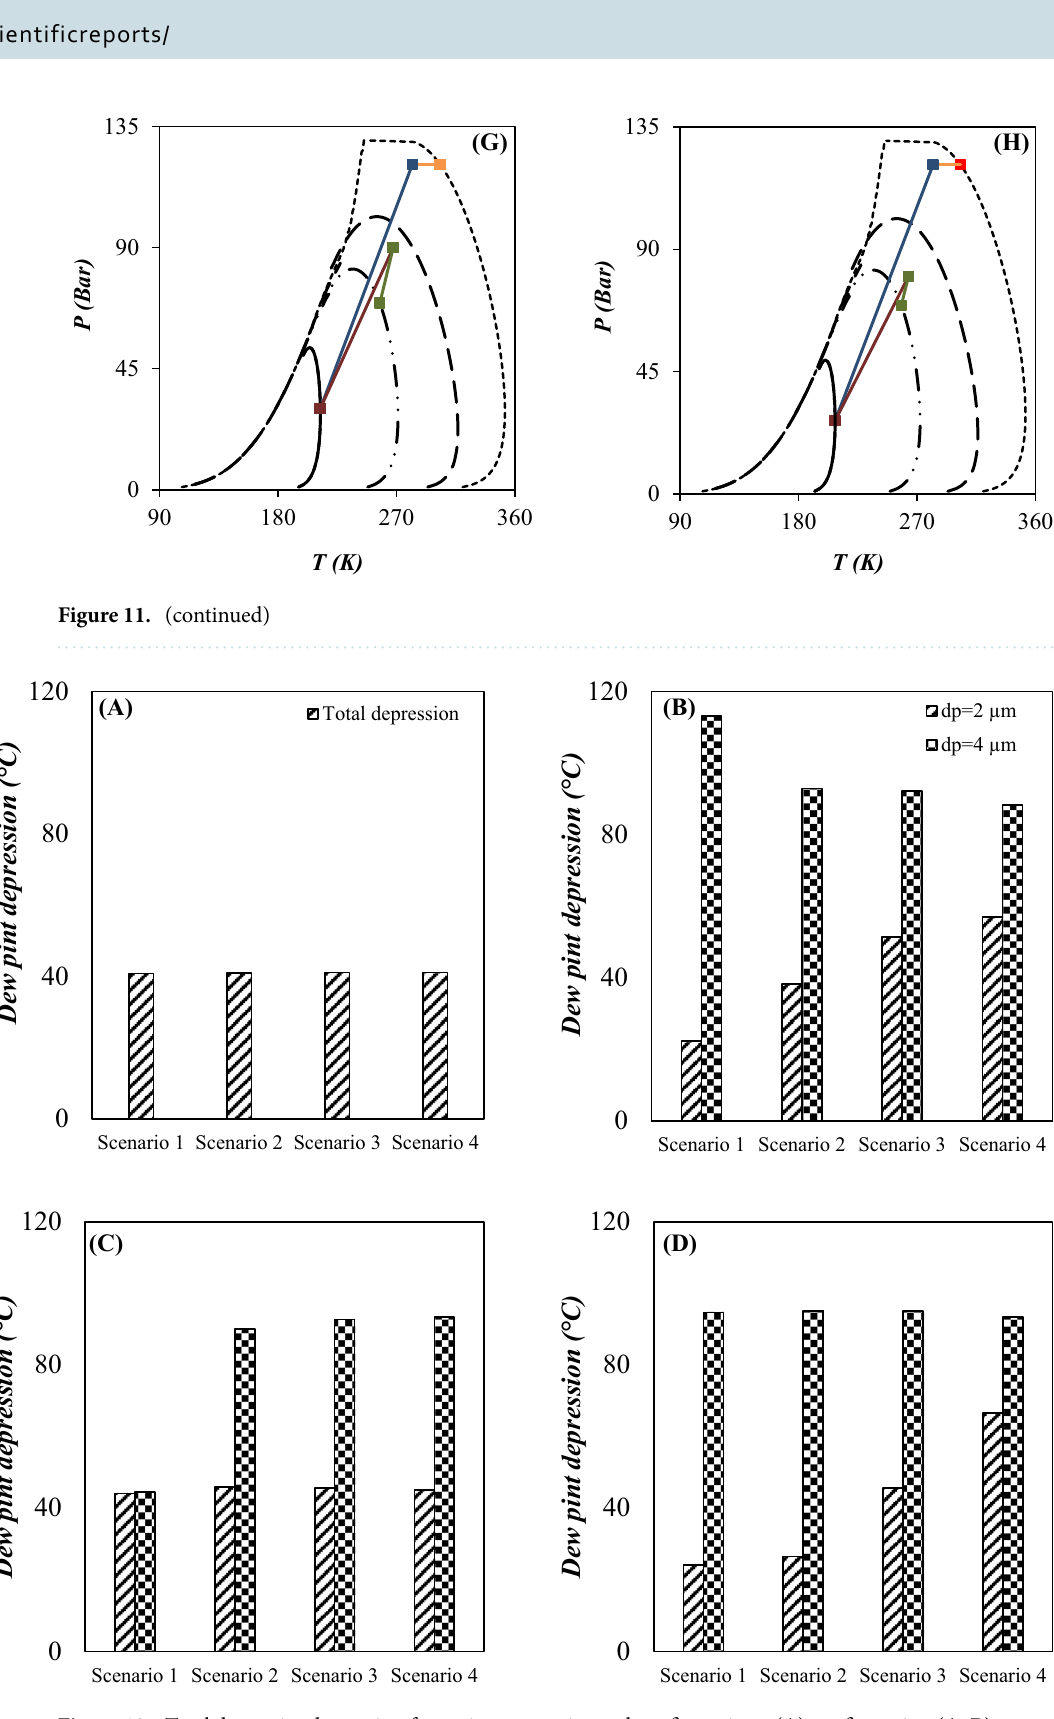
Figure 12. Total dew point depression for various scenarios and configurations: ( A ) configuration ( A, B ) configuration ( B, C ) configuration ( C and D ) configuration ( D